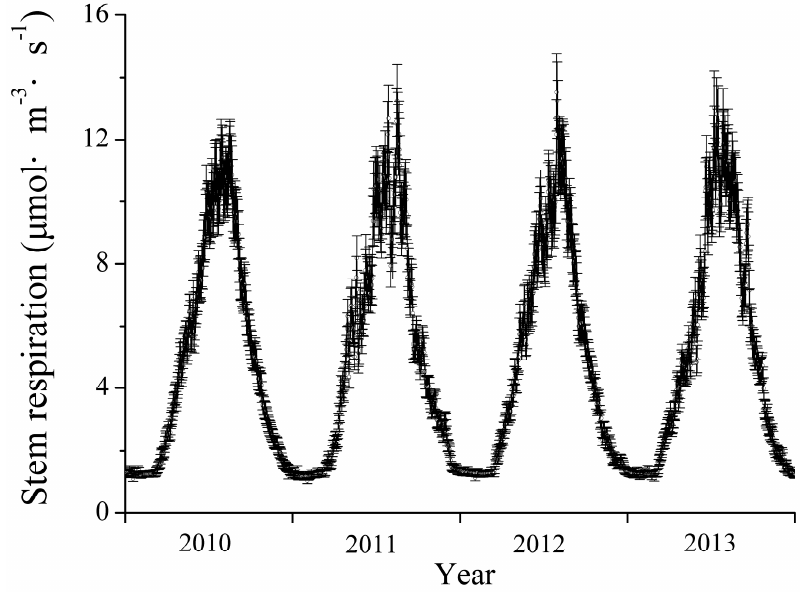
Figure 3. Daily mean stem respiration in the L. principis-rupprechtii forest during 2010–2013. Error bars are based on 0.5 h air temperatures as experimental unit ( n = 48).